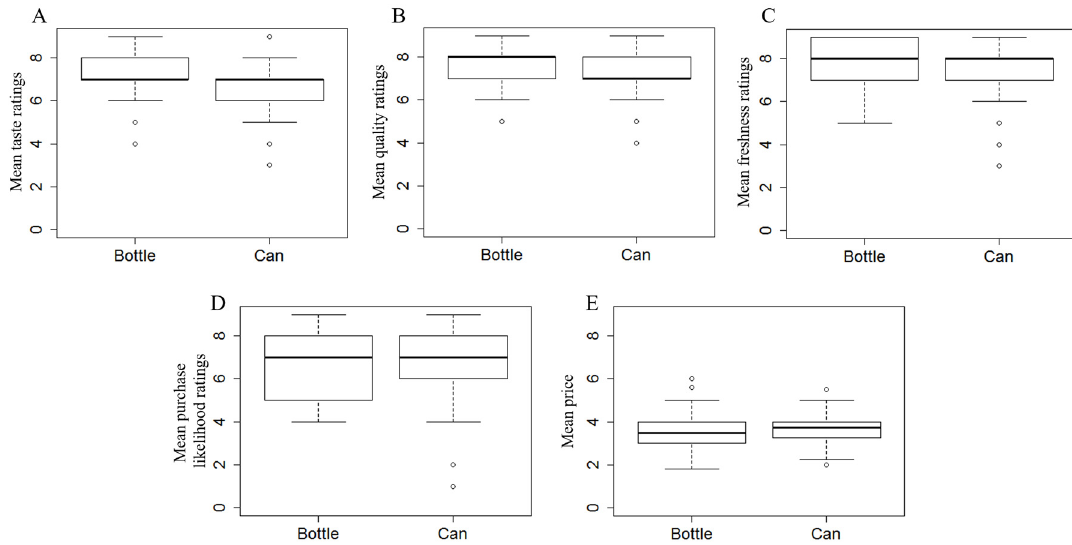
Figure 2. Boxplots for the different ratings as a function of group. Boxplots visualize the distribution of the data based on the minimum value, first quartile, median, third quartile, and maximum value. The points that are shown individually are those which fall in the lower or upper percentiles.